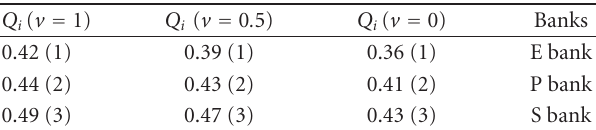
Table 7: The Q i values with v = 0, 0 . 5, 1 and preference order ranking by